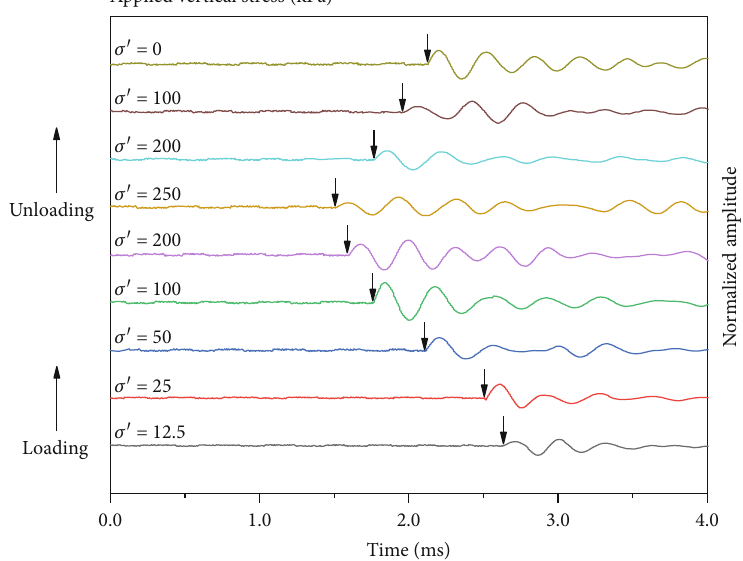
Figure 9: The typical received signal of a bender element during loading and